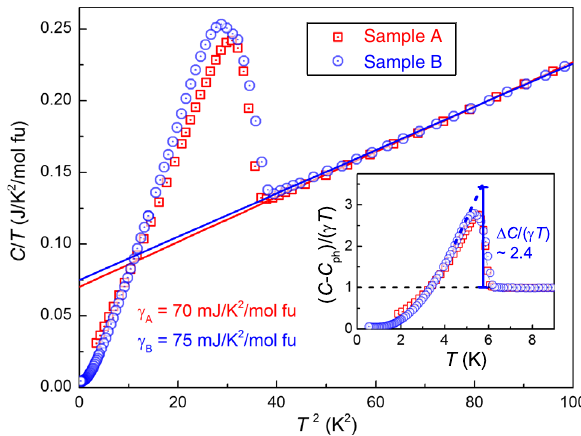
FIG. 4. Low-temperature specific heat for the K 2 Cr 3 As 3 poly- crystals. The main figure plots C=T versus T 2 , which extracts the ¼ β T 3 ) and electrons ( C ¼ γ T ), contributions from phonons ( C e ph and yields electronic specific-heat coefficients of γ ¼ 70 . 2 and 75 . 0 mJ K − 2 mol fu − 1 , respectively, for sample A and sample B. The inset plots ð C − β T 3 Þ = ð γ T Þ as a function of